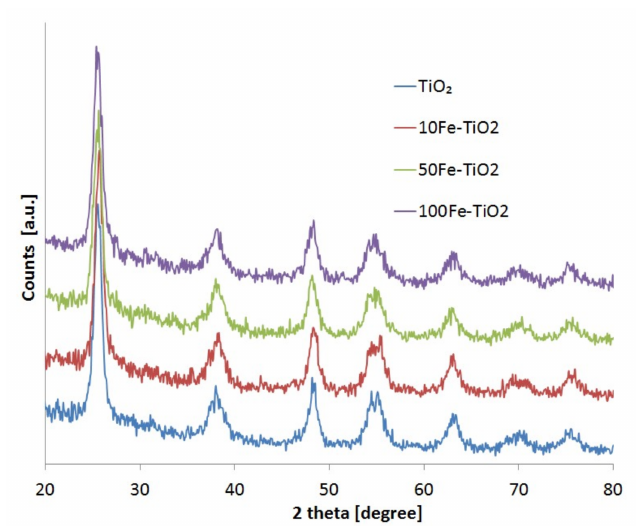
Figure 2. XRD spectra of the photocatalysts.